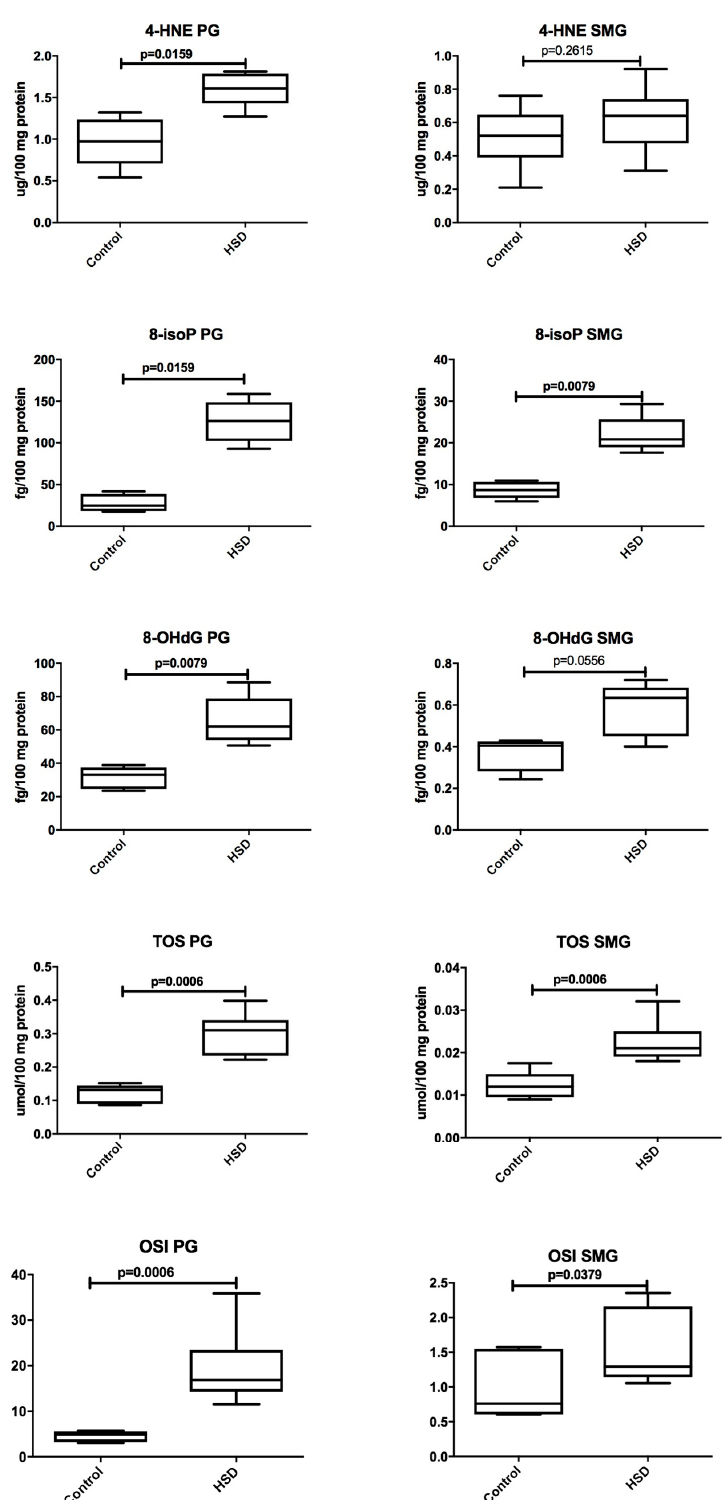
Figure 6. The effect of a high-sucrose diet (HSD) on protein oxidative damage. Abbreviations: AGE, advanced glycation end products, AOPP, advanced oxidation protein products, PC, protein carbonyls, PG, parotid glands, SMG, submandibular glands.